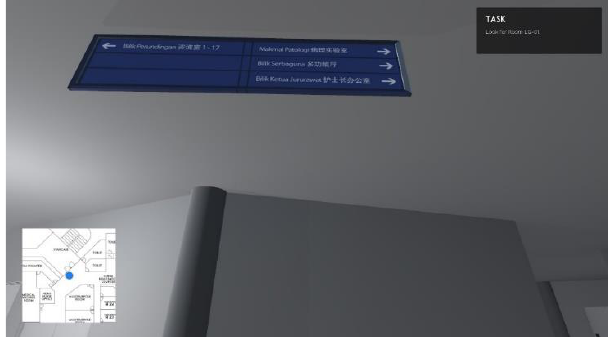
Figure 9. The map-call function display on the bottom left side of the screen.